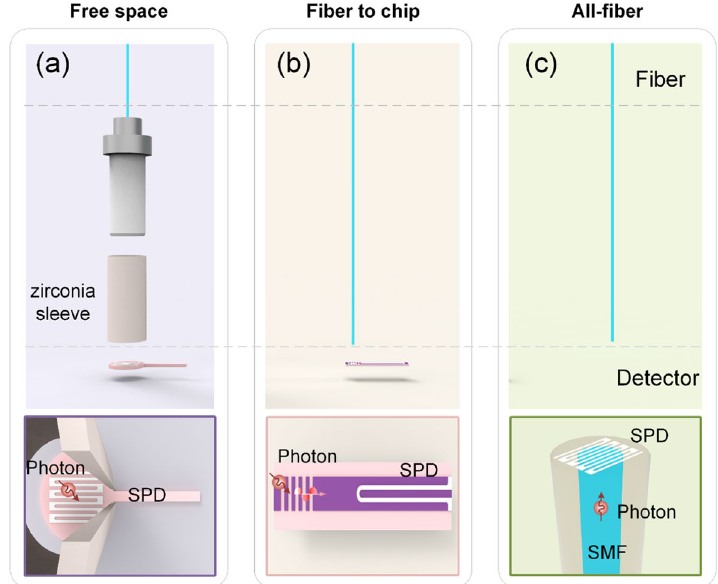
Fig. 1 a Schematic of conventional free space coupling. Lower panel: key‑shaped substrate with SPD [23, 33]. b Schematic of the conventional grating coupling from the fiber to the on‑chip waveguide. Lower panel: rectangular silicon substrate with SPD [34, 35]. c Schematic of the single‑mode fiber‑based direct coupling. Lower panel: fiber‑based